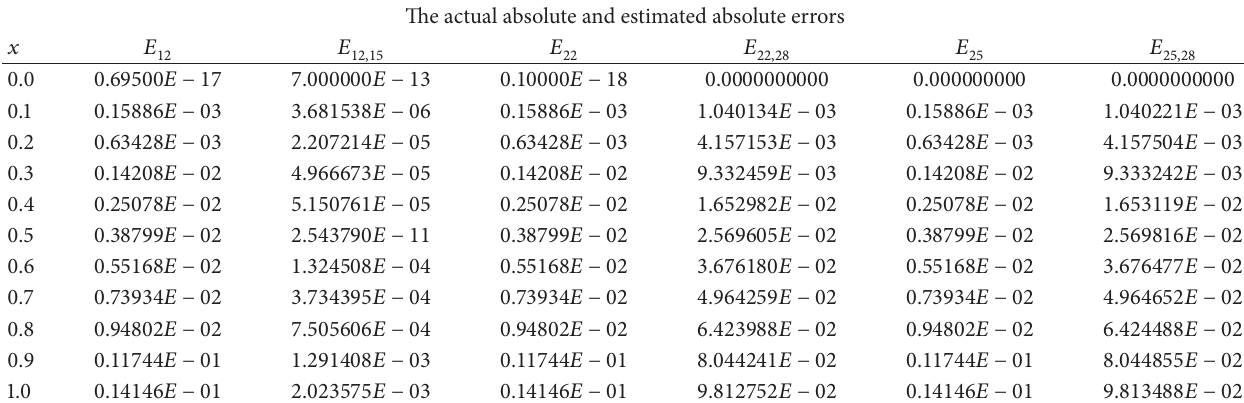
Table 7: Comparison of the actual and estimated absolute errors for 𝑁 = 12, 22, 25 and 𝑀 = 15, 28, 28 of Example 7. The actual absolute and estimated absolute